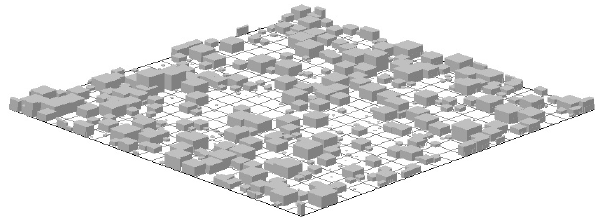
Fig. 6. Visualization of a geerated virtual surface used to calculate stopping probabilities (Screenshot). Cover percentage of deposited blocks=30%.